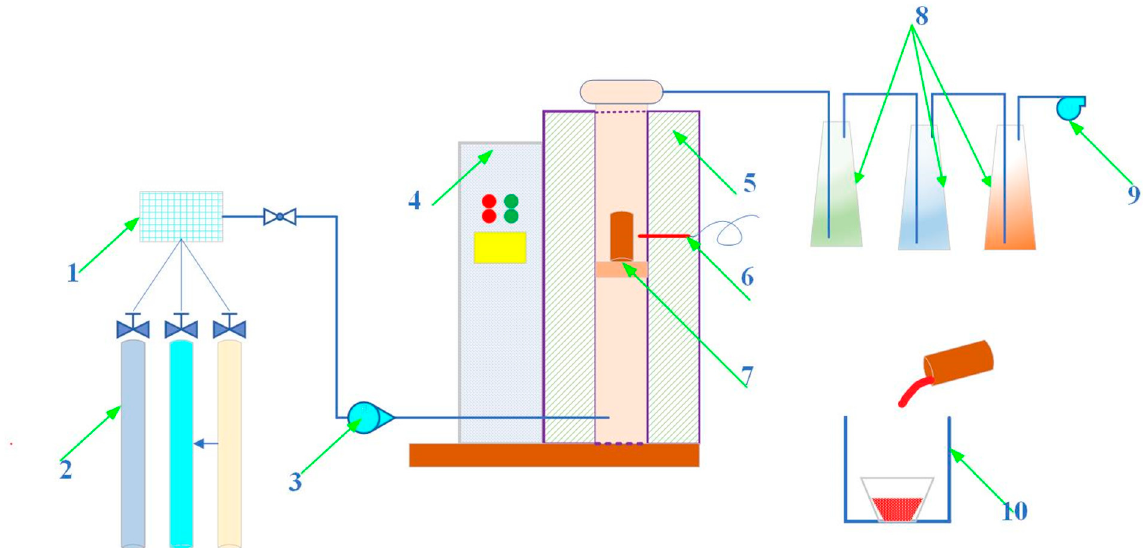
Figure 4. Schematic diagram of chlorination melting device for fly ash: 1-gas mixing chamber; 2- gas cylinder; 3- gas flow meter; 4- electrical control cabinet; 5-electrical furnace; 6- high-temperature 2-gas cylinder; 3-gas flow meter; 4-electrical control cabinet; 5-electrical furnace; thermocouple; 7- sample crucible; 8- exhaust absorbing flask; 9- exhaust fan; 10- cooling chamber.